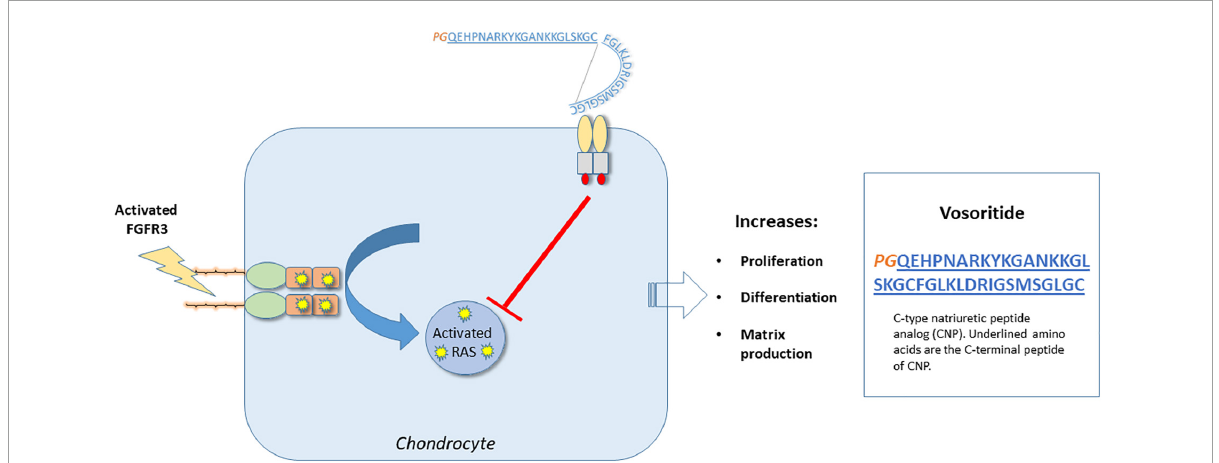
FIGURE3 Molecular mechanism of action – Vosoritide. Vosoritide is an analog of C-type natriuretic peptide (CNP), consisting of the last 37 amino acids of the C-terminal peptide of CNP (designated in blue). At the N-terminus, proline and glycine (designated by PG in orange) have been added, which helps to stabilize the peptide. It functions by binding to the C-type natriuretic peptide specific receptor (NPR2) to inhibit FGFR3 signaling at the level of RAF-1. In so doing, it promotes chondrocyte proliferation, differentiation, as well as matrix